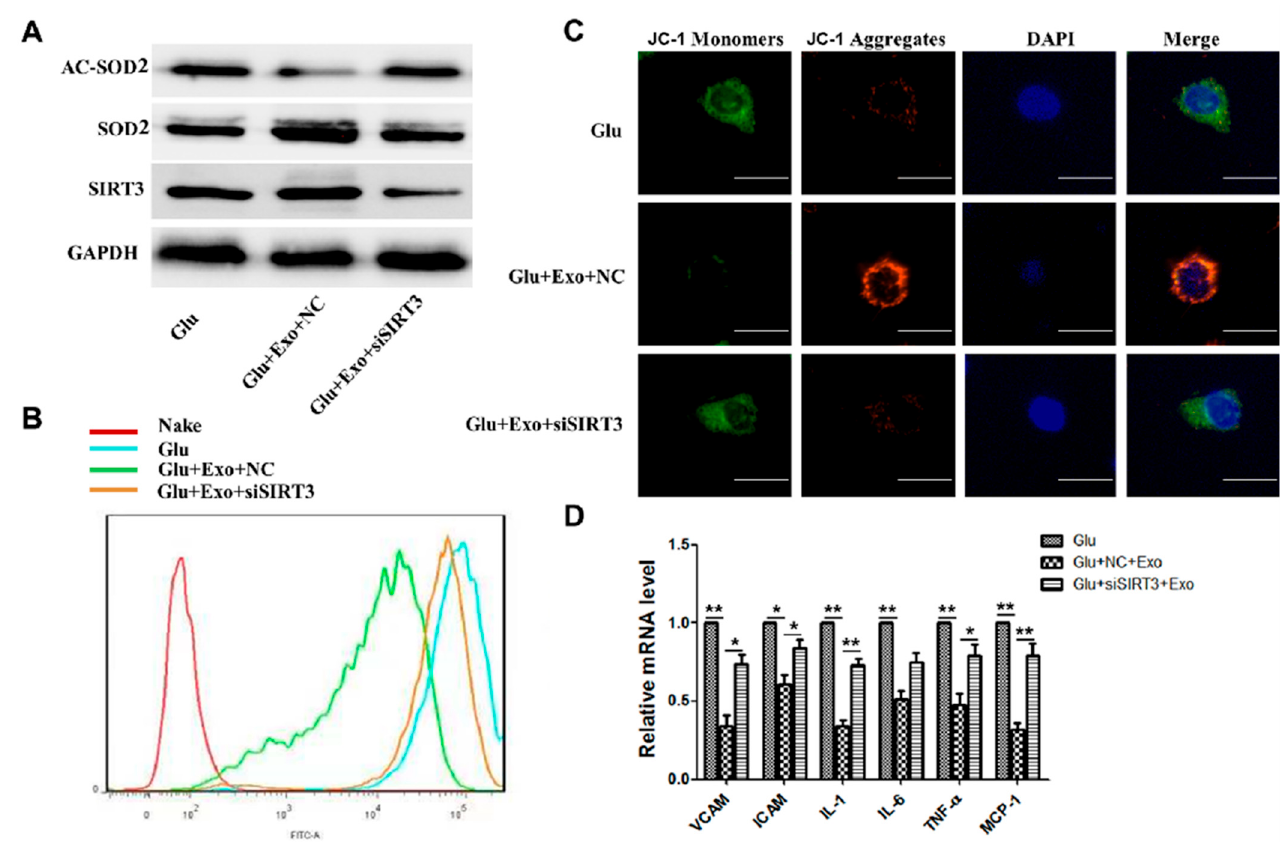
Figure 5. ADSC-exos exert their effects through SIRT3. ( A ) Western blot results showing HUVECs AC-SOD2, SOD2, and SIRT3 expression in the high-glucose group, high-glucose+exo+NC group, and high-glucose+exo+SIRT3 group. ( B ) HUVECs ROS levels were measured by flow cytometry. ( C ) HUVECs JC-1 signals were measured by fluorescence confocal microscopy (scale = 50 μ m). ( D ) mRNA levels of VCAM, ICAM, and inflammatory cytokines (IL1, IL6, TNF- α , and MCP-1) were analyzed by qRT-PCR. The data are shown as the mean ± SD (* p < 0.05, ** p < 0.01).